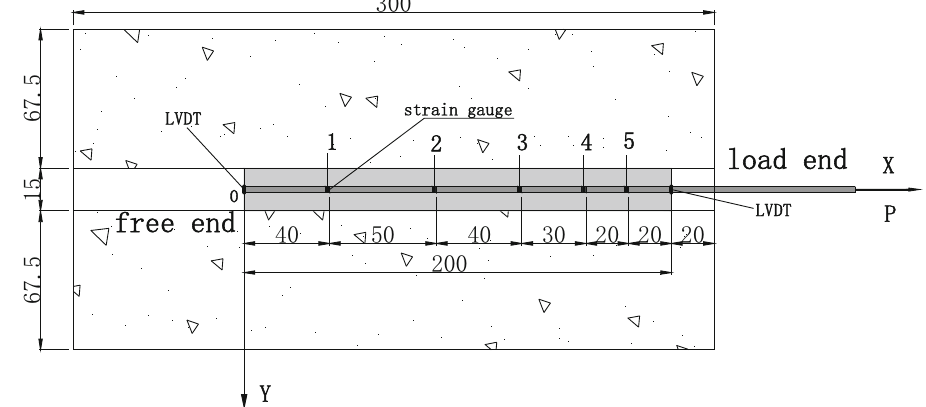
Fig. 4 Location of strain gauges on CFRP strip surface points 1, 2 … 5 (unit: mm)